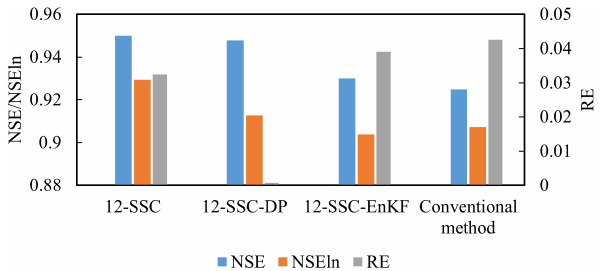
Figure 15. Simulation performance for streamflow in the Xun River basin. The results of NSE and NSE ln are shown on the primary axis, while the values of RE are shown on the secondary